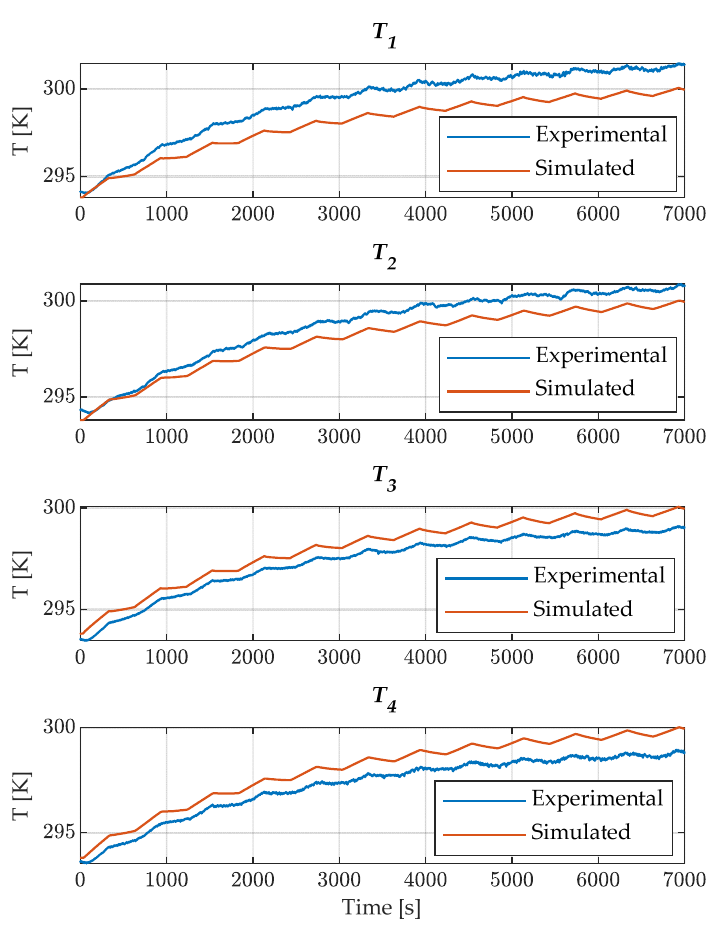
Figure 23. Thermocouples result for the ten cells test at 70 A.